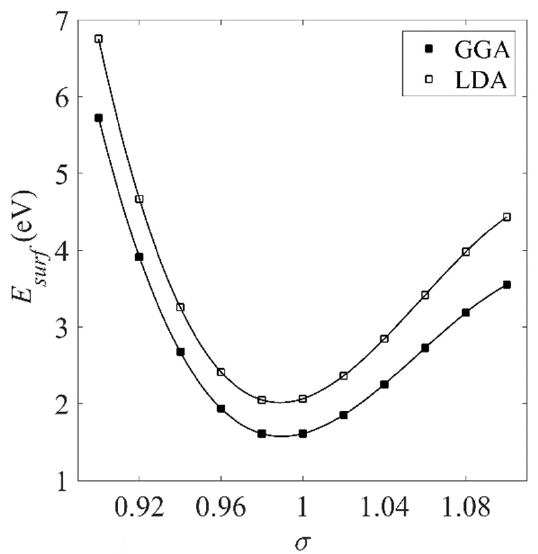
Figure 4. Surface energy E surf of unreacted Pt(111) estimated using both the LDA and GGA exchange- correlation functionals.